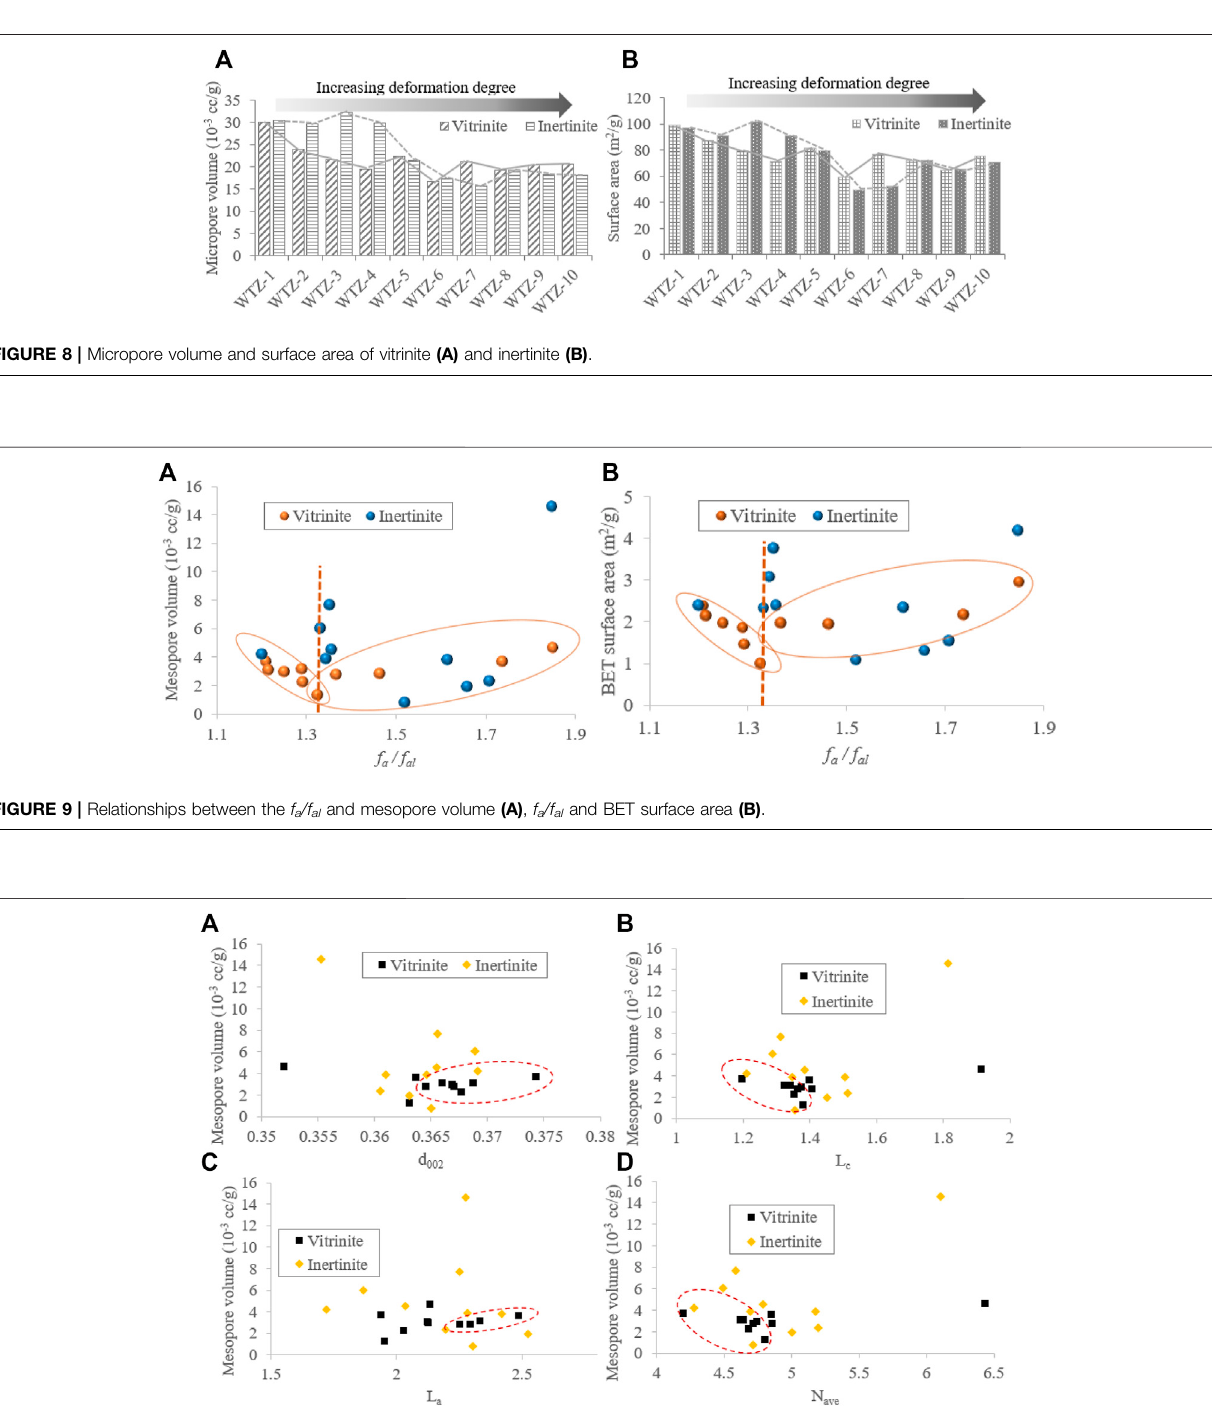
Frontiers in Earth Science |